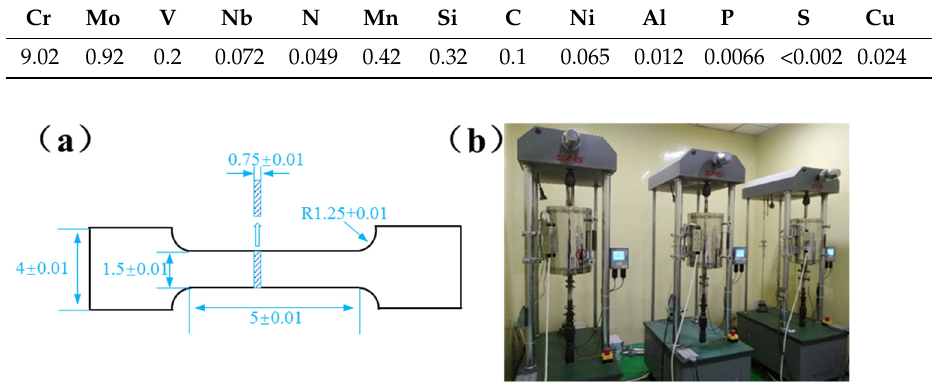
Figure 1. ( a ) Small creep specimen (unit: mm) and ( b ) GWT1104 high-temperature creep-testing